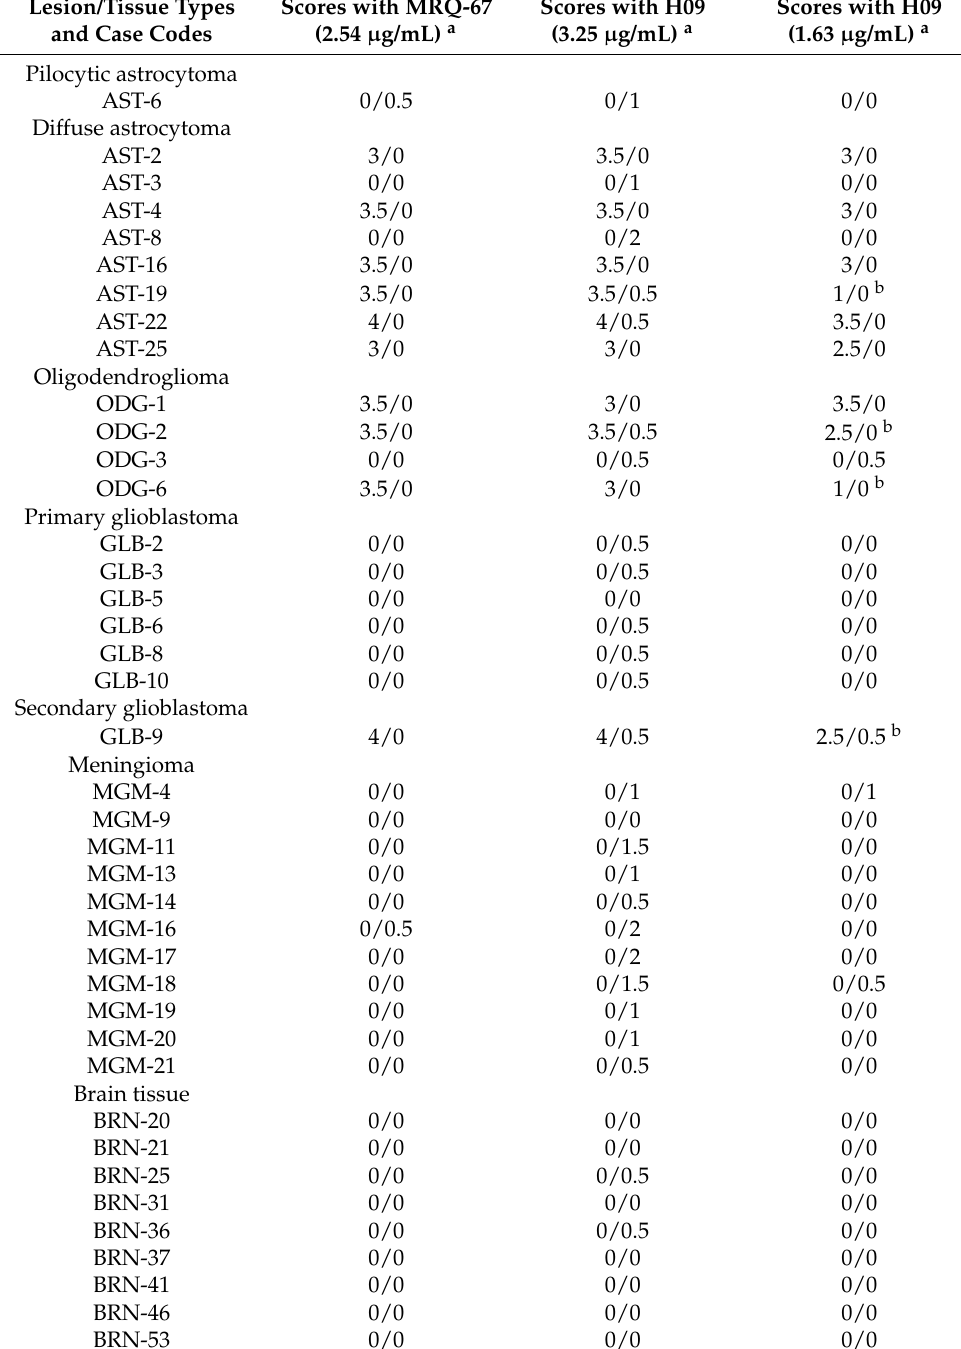
Table 5. Performance of the IDH1 R132H IHC in 41 FFPE samples, as demonstrated with the clone MRQ-67 or with H09 at different working